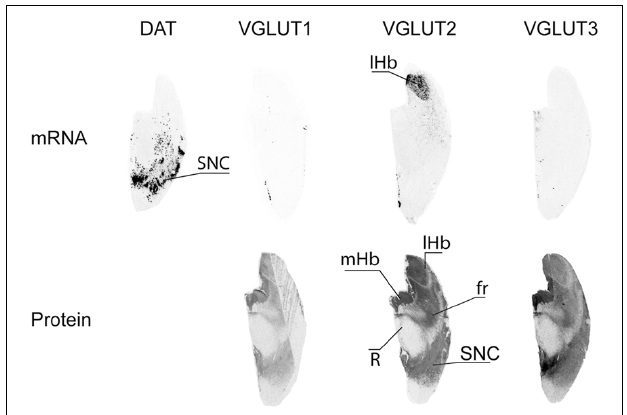
FIGURE 7 | Distribution of VGLUT1-3 mRNA and protein in substantia nigra. Substantia nigra pars compacta (SNC) was identified by detection of the transcript coding for the dopamine transporter (DAT). Abbreviations: fr, fasciculus retroflexus; lHb, lateral habenula; mHb, medial habenula; R, red nucleus.